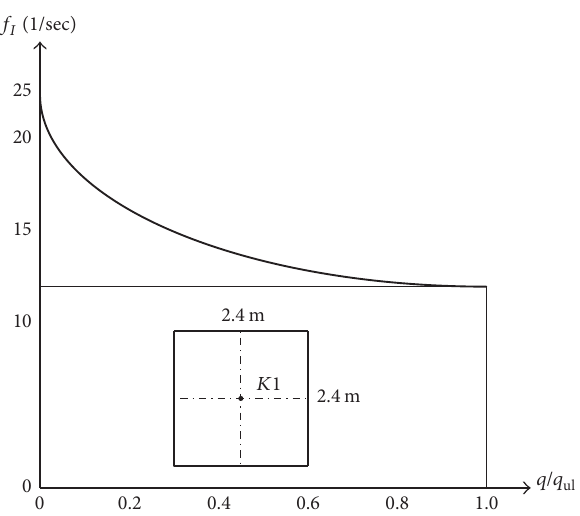
Figure 1: Dominant technical frequency, 𝑓 𝐼 , versus load ratio, 𝑞/𝑞